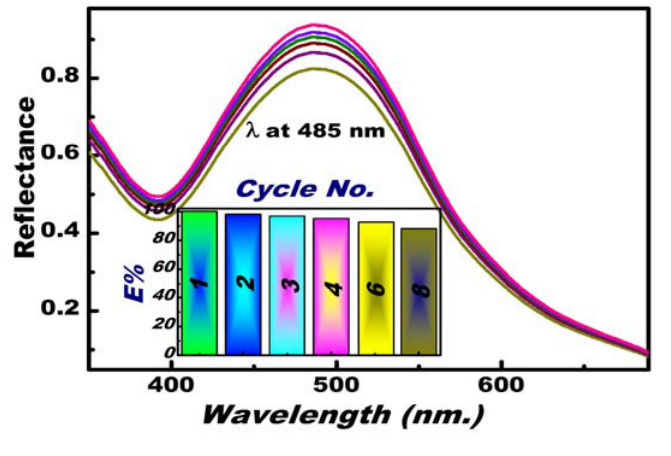
Figure 5. Multiple reuse cycles of the sensor for Hg(II) ions after eight